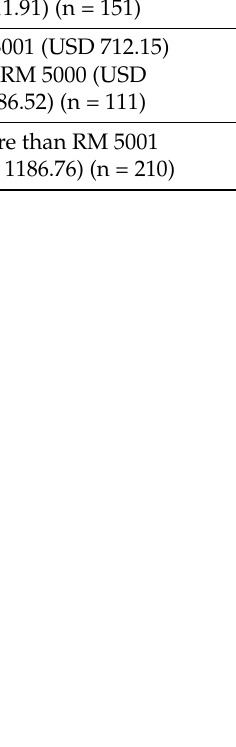
Table 3. Rejection factors with regard to liquid formulations, Section 3 (n =